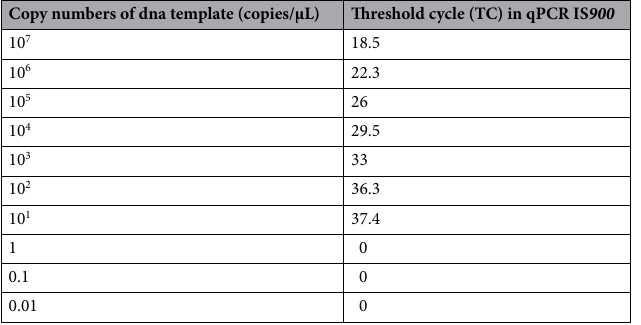
Copy numbers of dna template